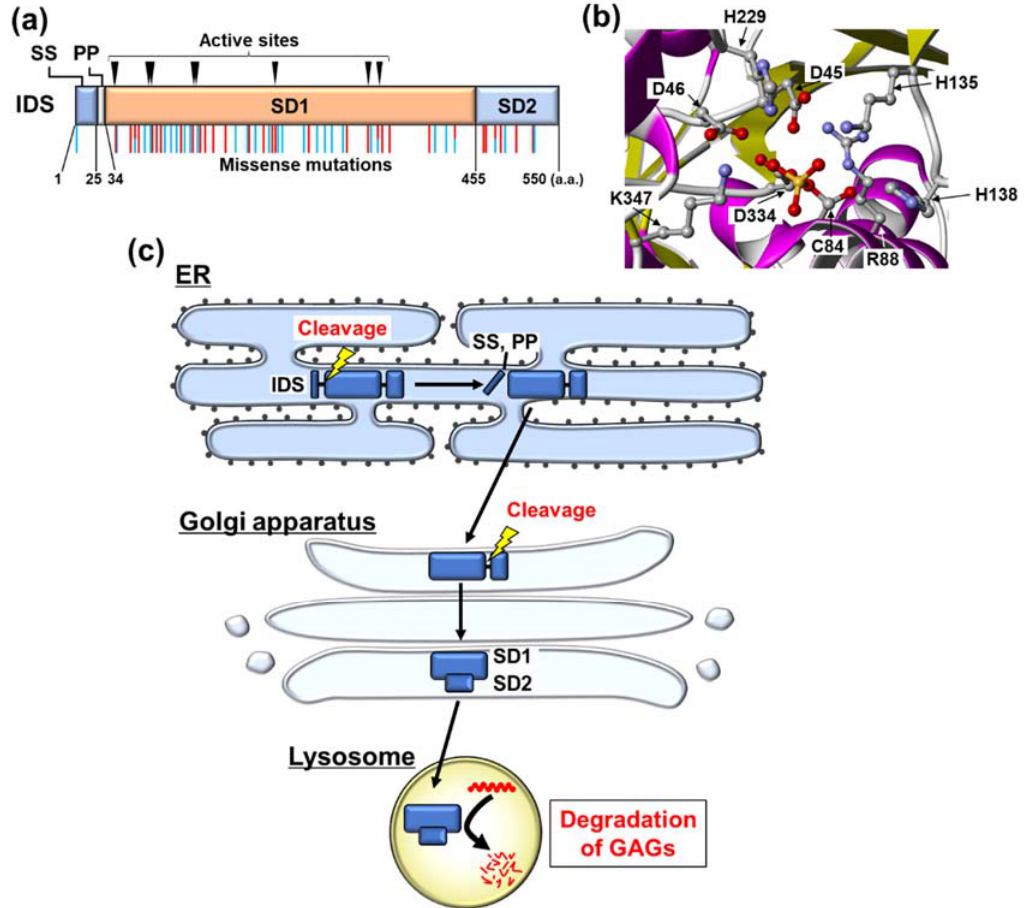
Figure 1. The peptide features of iduronate-2-sulfatase (IDS) and its processing steps in organelles. ( a ) Domain structure, active sites, and representative pathogenetic mutations of IDS. IDS protein consists of a signal peptide (SS), a propeptide (PP), subdomain 1 (SD1), and subdomain 2 (SD2). SD1 contains nine active-site residues: D45, D46, C84, R88, K135, H138, H229, D334, and K347. Representative residues that are mutated are shown as sticks on the structures of IDS. Red: severe type, Blue: attenuated type, Red and Blue: both attenuated and severe types are reported. ( b ) Crystal structure of active